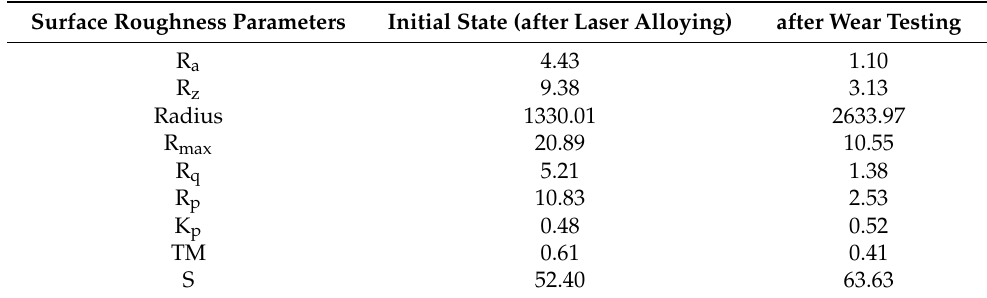
Figure 12. Profilograms ( a ) and reference curves ( b ) of surface layers for AISI 420 steel after laser alloying with a plaster of 85Nb + 15% liquid glass (curve 1) and after wear testing (curve 2). Table 1. Surface roughness parameters for AISI 420 steel after laser alloying with a plaster of 85Nb + 15% liquid glass ( μ m).